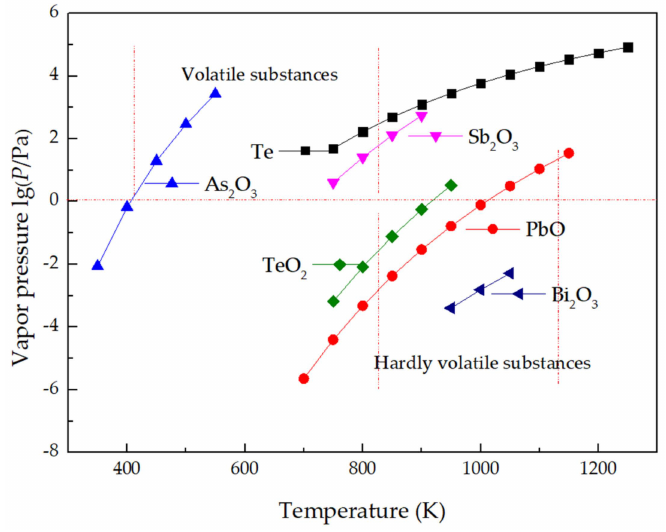
Figure 3. Relationship between the saturated vapor pressure and temperature of each metal